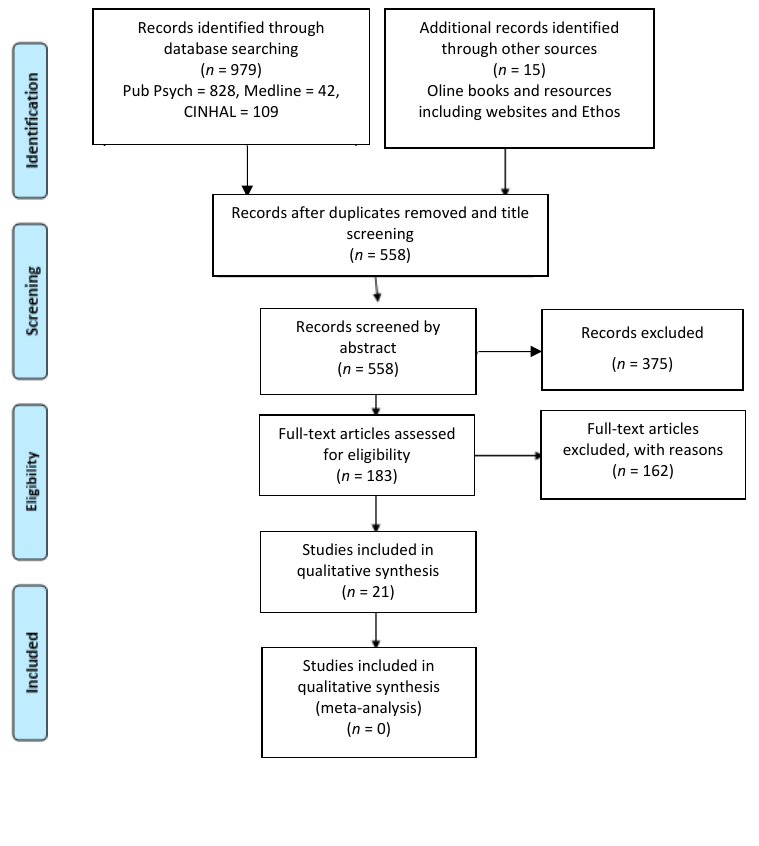
Figure 1. Search